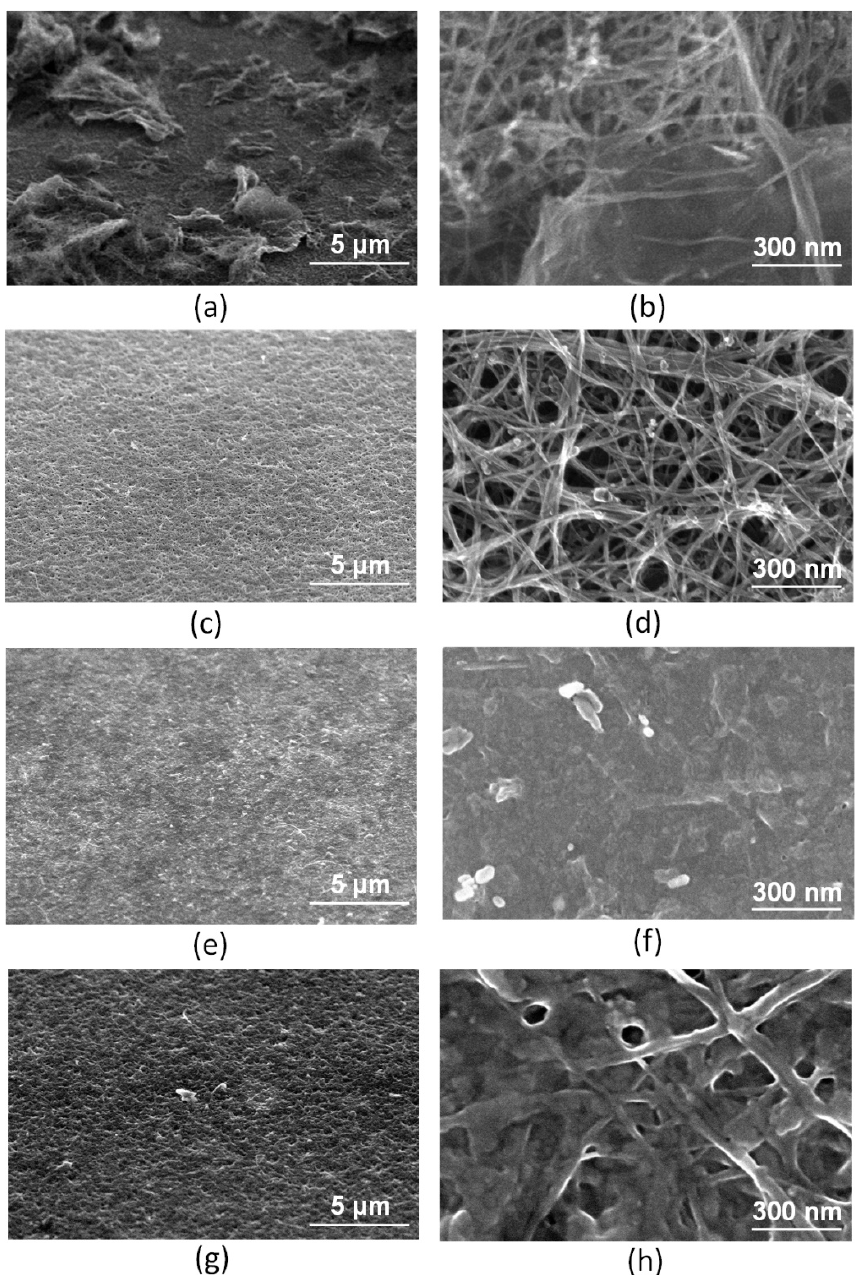
(Figure 6c,d), dispersion 2 based on rGO (Figure 6e,f), and dispersion 3 based on rGO and SWCNT (Figure 6g,h).